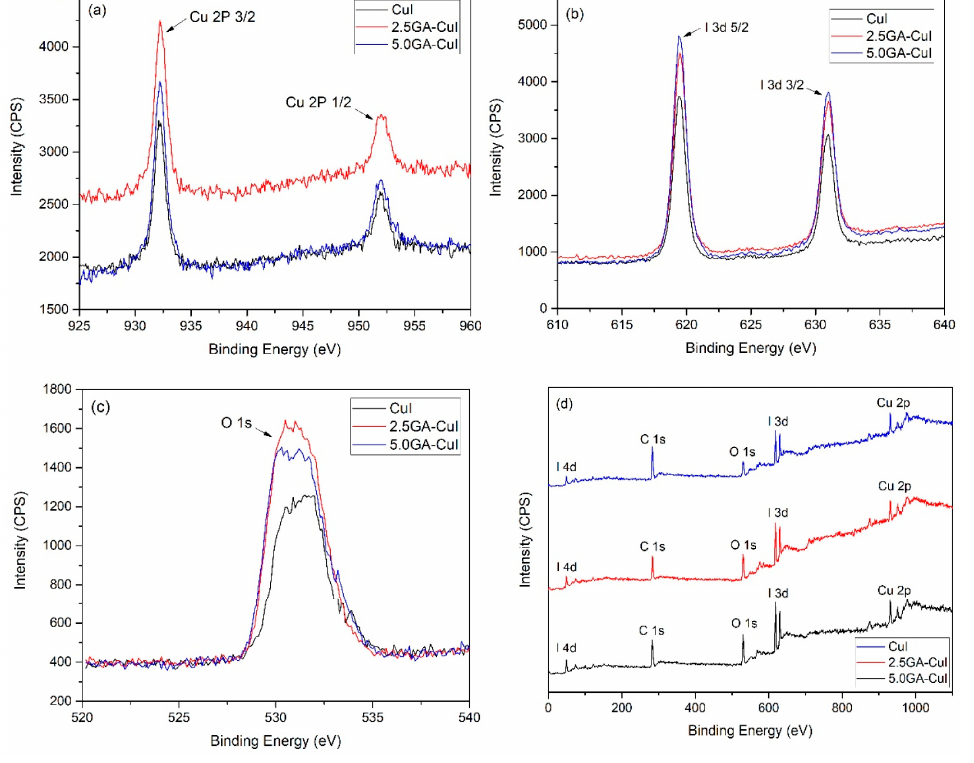
Figure 2. XPS spectra of ( a ) Cu 2p, ( b ) I 3d, ( c ) O 2 s and ( d ) survey spectra of CuI NPs.